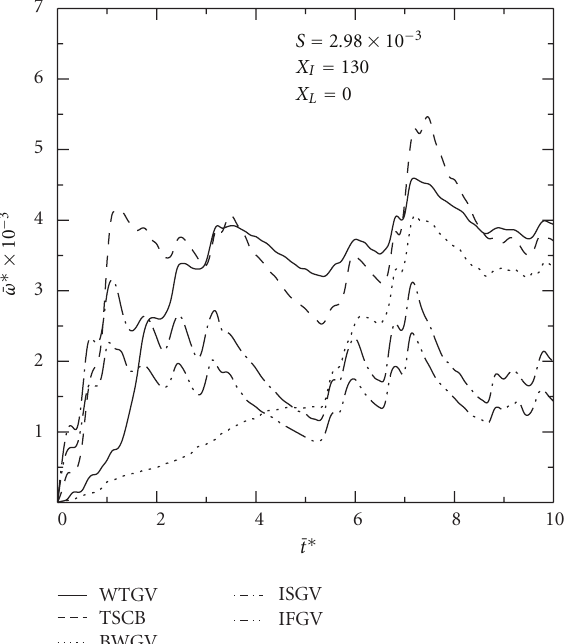
Figure 13: Comparison of mean e ffi ciency under irregular wave conditions.